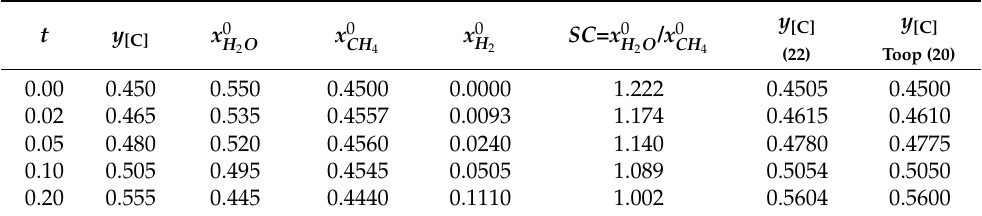
Table 4. Rangef carbon precipitation [C] = f ( t , y ) for T = 1000 K in system (CH 4 /H 2 )–H 2 O according to the numerical calculations and Toop’s